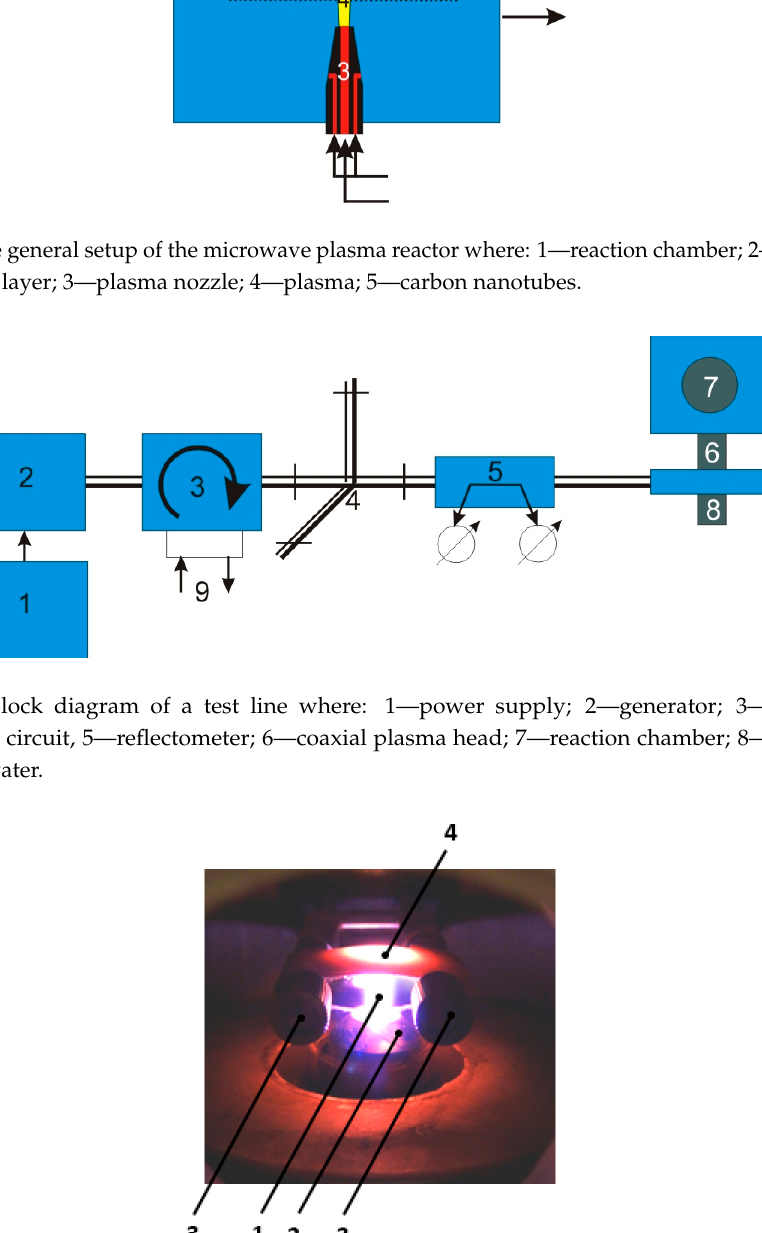
Figure 4. Photo of reaction zone of the microwave plasma reactor for carbon nanotube (CNT) synthesis on a metal substrate where: 1—microwave plasma; 2—plasma head; 3—substrate feeder; 4—substrate.